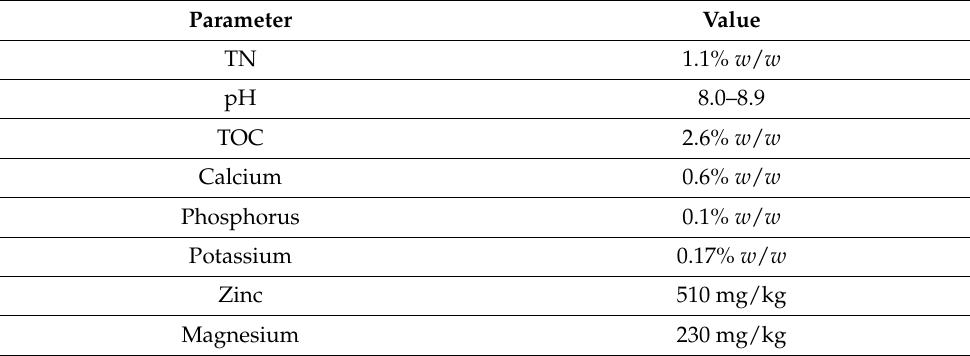
Table 8. Chemical analysis of the liquid fertilizer obtained from the